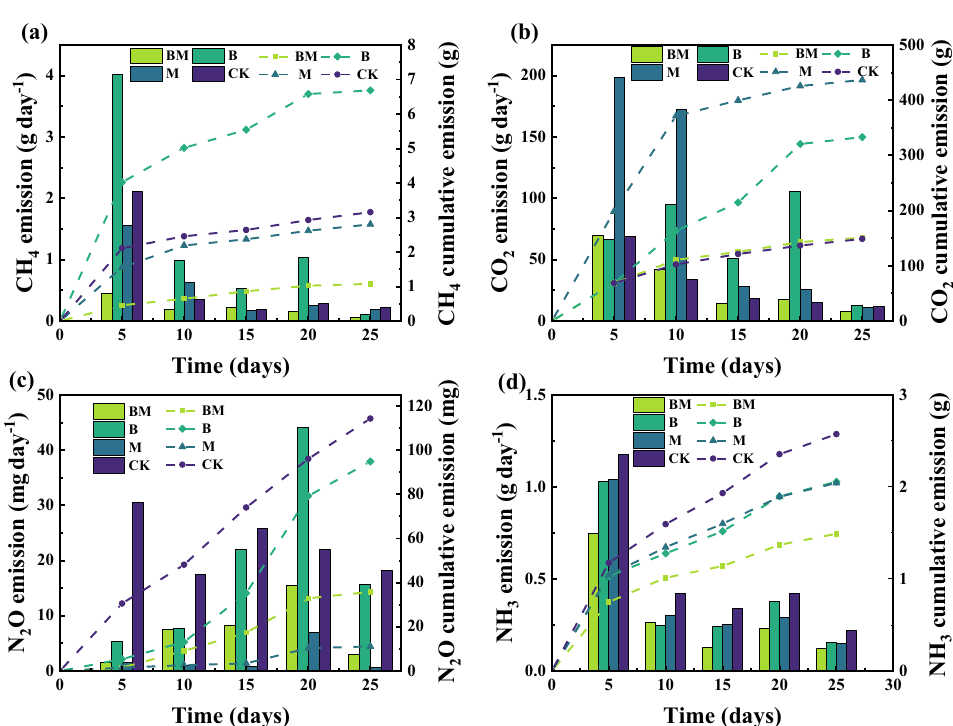
Fig. 5 Emissions of CH 4 ( a ), CO 2 ( b ), N 2 O ( c ), and NH 3 ( d ) in different treatments during composting. CK: sheep manure compound microbial agents; B: CK before being naturally